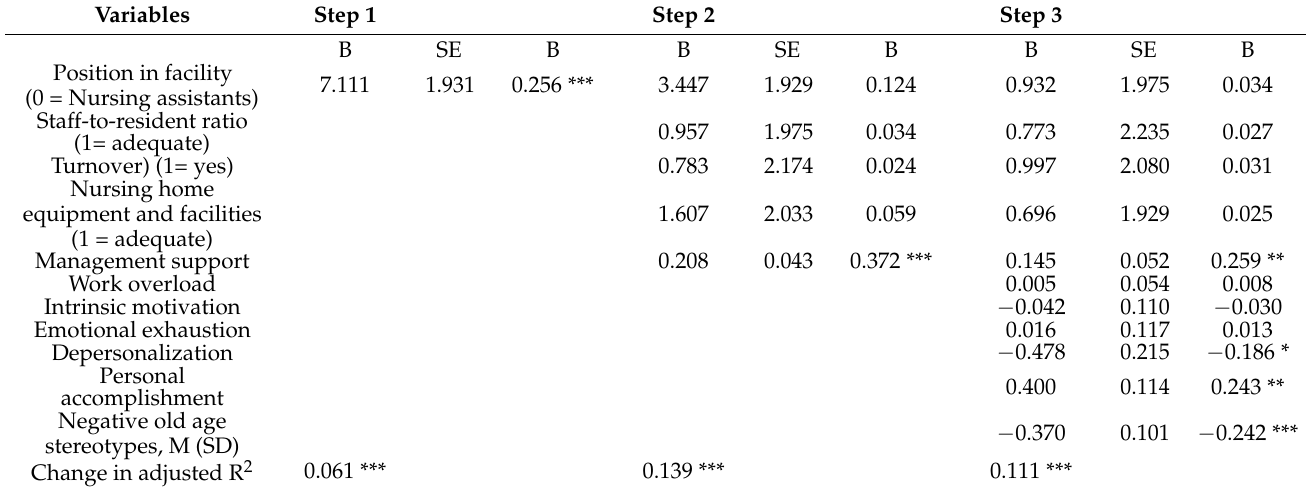
Table 2. Hierarchical regression analysis examining the associations between assessed variables and good care